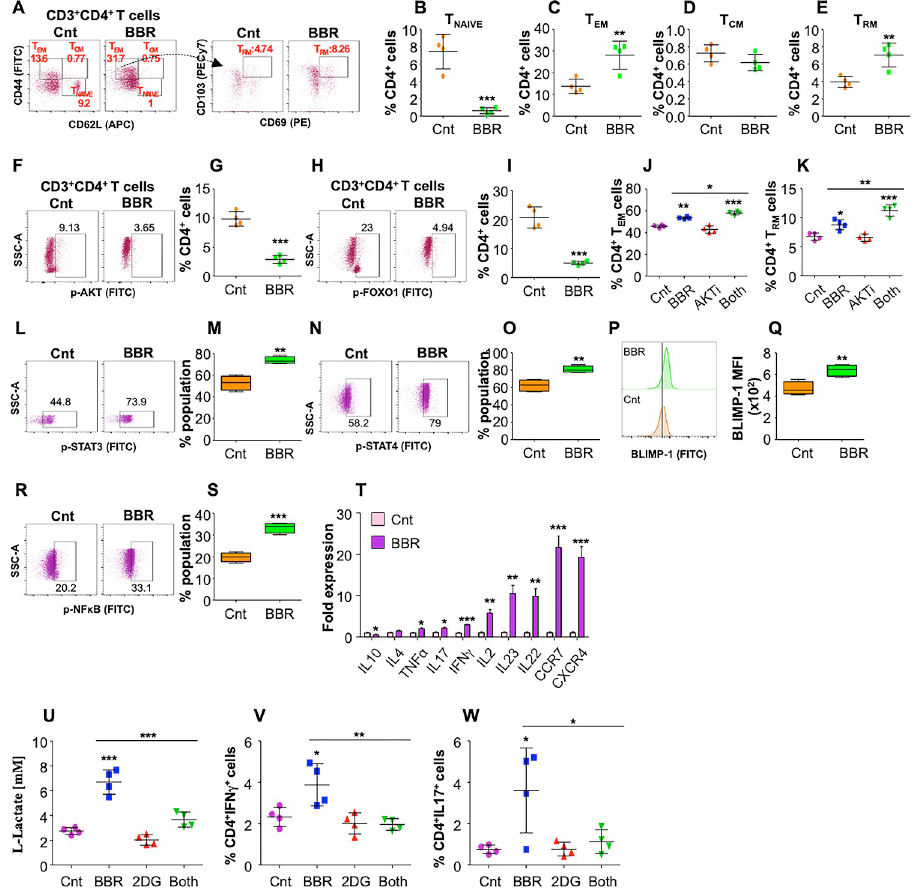
Fig 4. BBR induces expansion of antigen-specific memory T cells by targeting TCR signaling and glycolysis. Splenocytes isolated from M . tb infected mice were ex vivo stimulated with M . tb CSA and treated with BBR (10 μ g/ml) for 48 h. Ex vivo stimulated splenocytes were surface stained with α -CD3 (Pacific Blue), α -CD4 (PerCPCy5.5), α -CD8 (APCCy7), α -CD69 (PE), α -CD103 (PECy7), α -CD62L (APC) and α -CD44 (FITC). (A) Representative dot plots and the percentage of (B) CD4 + T NAIVE cells, (C) CD4 + T EM cells, (D) CD4 + T CM cells and (E) CD4 + T RM cells after BBR treatment. (F-I) To analyse the activation status of key signaling molecules and transcription factors, the cells were stained with α -CD3 (Pacific Blue) and α -CD4 (PerCPCy5.5) followed by intracellular staining with antibodies against p-AKT and p-FOXO1 (see methods). (F) Representatives FACS scatter plots and (G) the percentage of CD4 + T cells expressing pAKT. (H&I) Representative scatter plots and the percentage of CD4 + T cells expressing p-FOXO1. (J&K) Ex vivo stimulated splenocytes were treated with BBR (10 μ g/ml), AKTi (2.5 μ M) or both for 48 h followed by surface staining with α -CD3 (Pacific Blue), α -CD4 (PerCPCy5.5), α -CD69 (PE), α -CD103 (PECy7). (J) Percentage of CD4 + T EM and (K) CD4 + T RM cells. (L-S) Stimulation of transcription factors involved in memory responses were examined for which the cells were stained with α -CD3 (Pacific Blue) and α -CD4 (PerCPCy5.5) followed by intracellular staining with antibodies against p-STAT3, p-STAT4, BlIMP-1 and p-NF κ B (see methods). Representatives FACS scatter plots and percentage of CD4 + T cells expressing (L&M) p-STAT3, (N&O) p-STAT4, (P&Q) Blimp-1 and (R&S) p-NF κ B. (T) Expression of cytokines in M . tb specific T cells with or without BBR treatment. (V-X) Ex vivo stimulated splenocytes isolated from M . tb infected mice were treated with BBR (10 μ g/ml), 2-Deoxy-D-glucose (2DG; 200 mM), both or left untreated for 24 h. (U) L-Lactate present in the supernatant of treated splenocytes. (V) Percentage of CD4 + IFN γ + T cells and (W) CD4 + IL17 + T cells. The data values represent mean ± SD (n = 3–4). � p < 0.05, �� p < 0.005, ��� p <